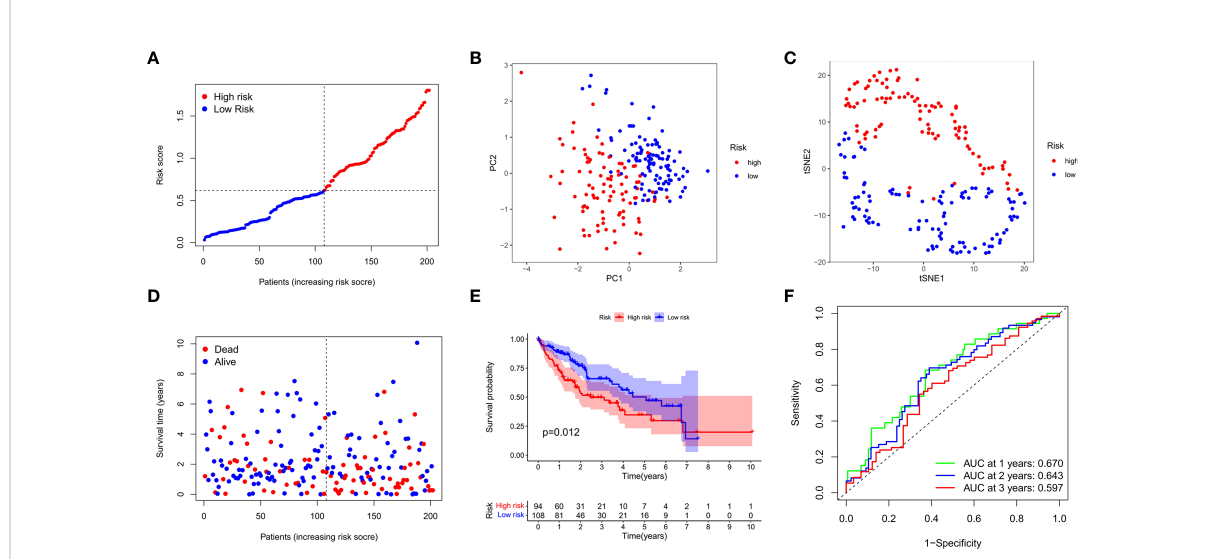
FIGURE 4 Validation of the prognostic model in the test cohort. (A) Distribution of patients in the test cohort was shown based on the median risk score in the training group. (B) PCA was plotted for survival status of HCC patients in the test cohort. (C) T-SNE analysis was conducted for survival status of HCC patients in the test cohort. (D) The survival status for each patient was displayed in the high- and low-risk groups. (E) Kaplan- Meier survival curves between low- and high-risk groups were shown in the test cohort. (F) ROC curves were assessed for survival status corresponding to 1, 2, and 3 years respectively.